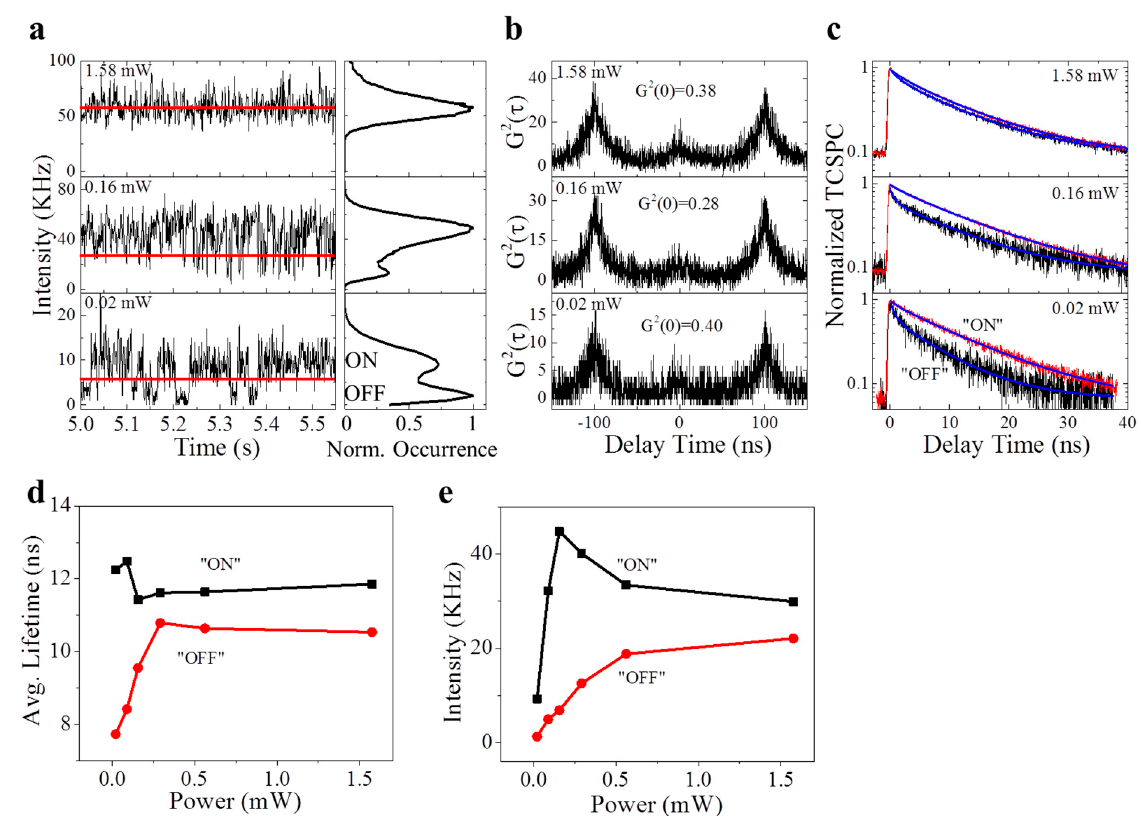
Figure 4. Power-dependent measurement and analysis on the NV center under the illumination of a 532 nm laser beam. ( a ) 0.5-s fragments of a 60-s time trajectory of fluorescence emission from an NV center under the excitation of a 532 nm laser at a different power, and corresponding histograms on the right. The fluorescence intermittency becomes faster at a higher power. Red lines in ( a ) represent the ON/OFF “threshold” for analyzing the emission statistics. ( b ) G2 measurements on the NV center at different laser powers. ( c ) Normalized TCSPC decay curves of “ON” and “OFF” emission states identified in ( a ) at different excitation powers. It becomes difficult to resolve “ON” and “OFF” at a high excitation power. ( d ) Calculated average fluorescence lifetime at different laser powers obtained from ( c ). ( e ) Power-dependent intensity of the “ON” and “OFF” states obtained in ( a ).